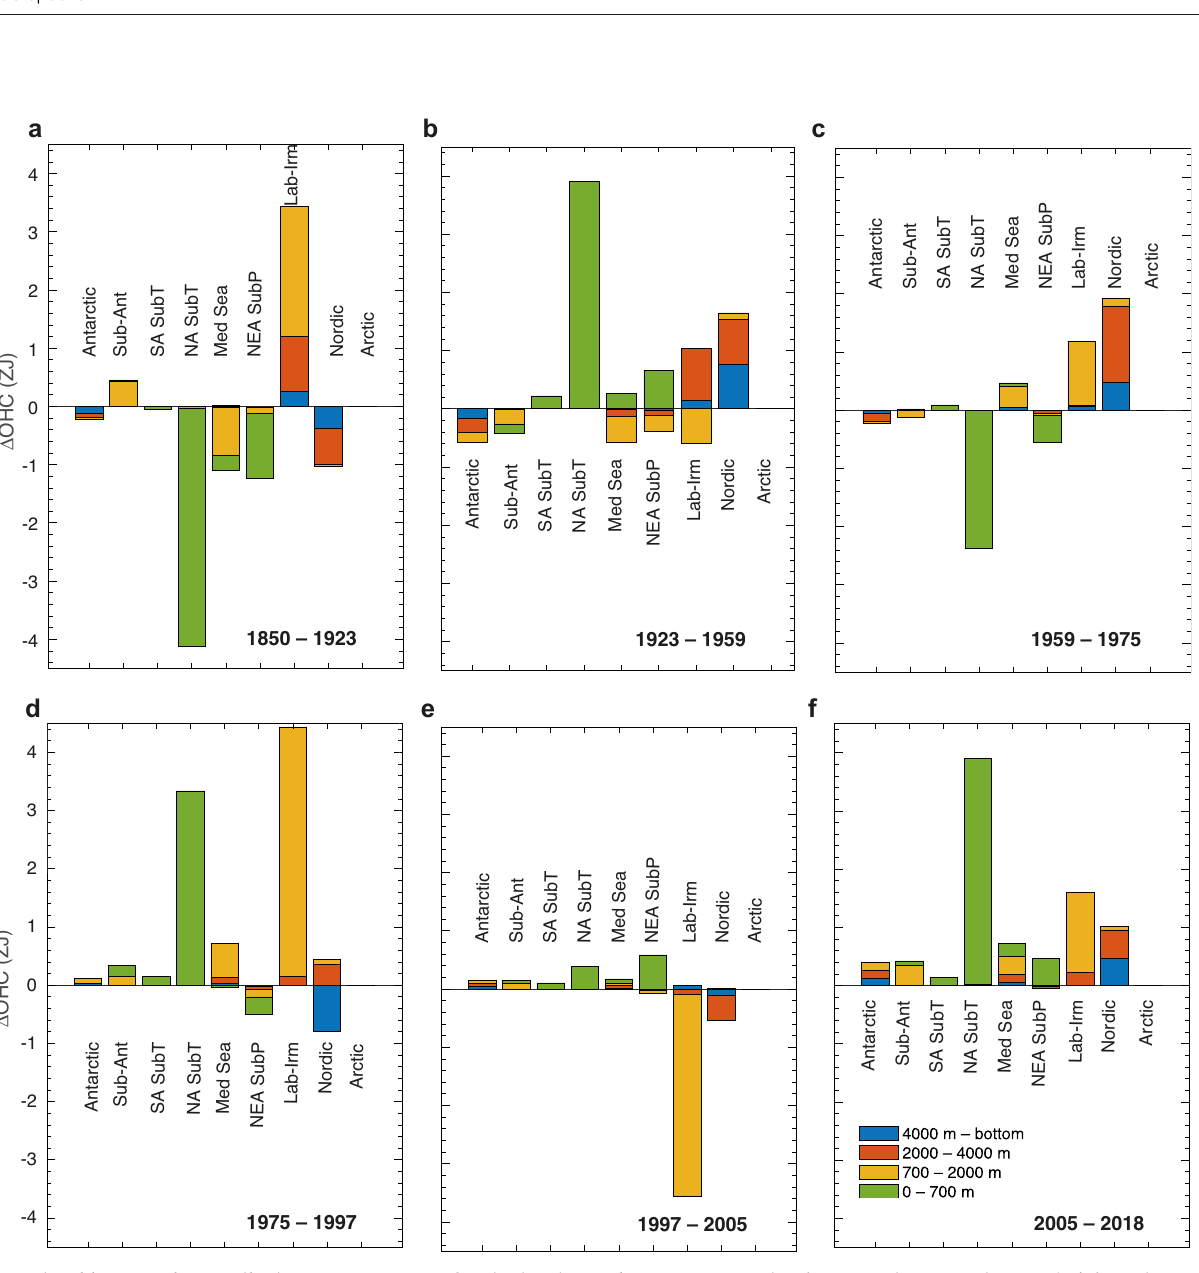
Fig. 5 Regional heat uptake contributions to 25°N Δ OHC for six time intervals. Same as Fig. 3 but for excess heat contributions (ZJ) from the source regions for different time intervals at 25°N, which we observed, have shaped the 0 – 700 m Δ OHC: ( a ) 1850 – 1923, ( b ) 1923 – 1959, ( c ) 1959 – 1975 ( d ) 1975 – 1997, ( e ) 1997 – 2005, and ( f ) 2005 –